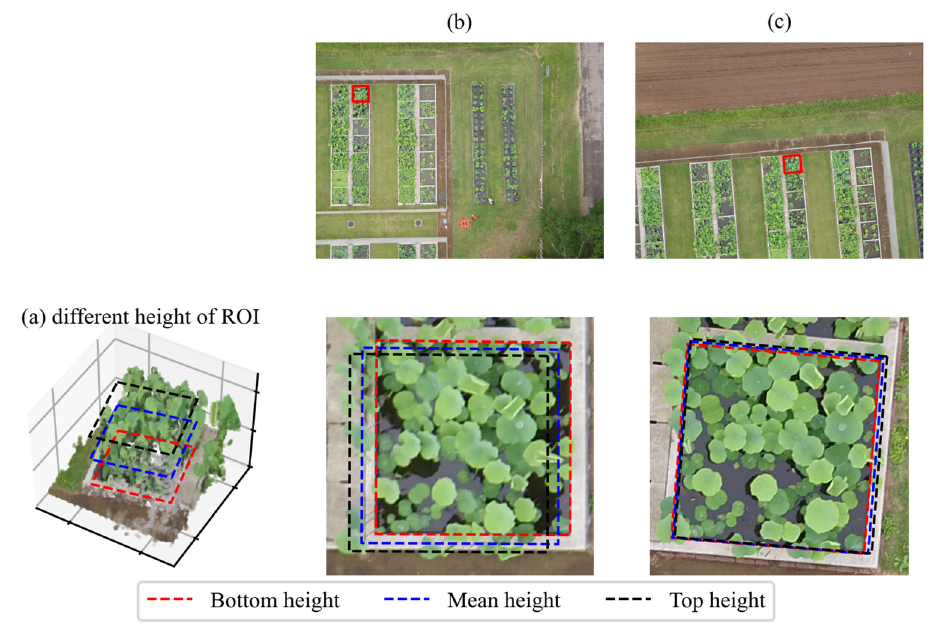
Figure 6. Effects of the ROI position and ROI height on the transformation. ( a ) Three different height choices of ROIs (5th percentile, mean, 95th percentile) by point cloud display, and ( b ) and ( c ) two different ROI positions on the raw images and related ROI transformation results.